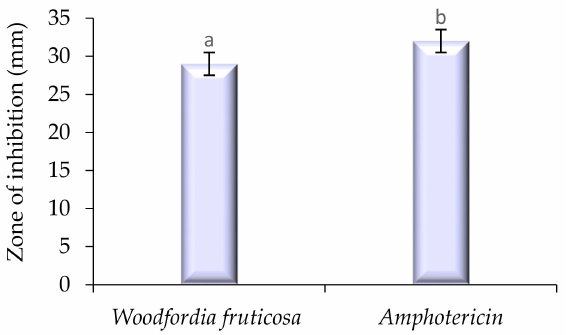
Figure 4. Antifungal activity (zone of inhibition) of Woodfordia fruticosa flower’s dry extract against Candida albicans. Data are presented as means ± SEM ( n = 3); a, b: Means within the column with different lowercase superscripts are significantly different ( p <